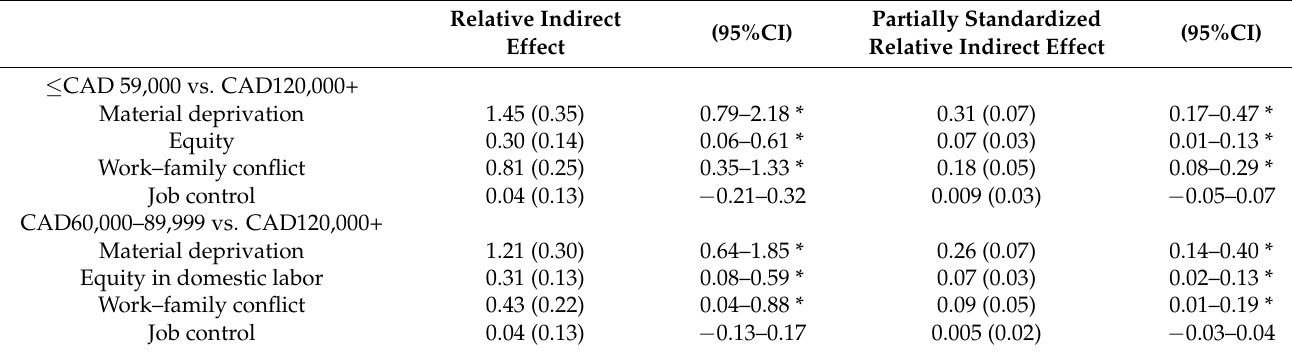
Table 4. Relative indirect effects and partially standardized indirect effects of income on psychological distress through material deprivation, equity in unpaid work, work–family conflict, and job control ( n = 512) 1